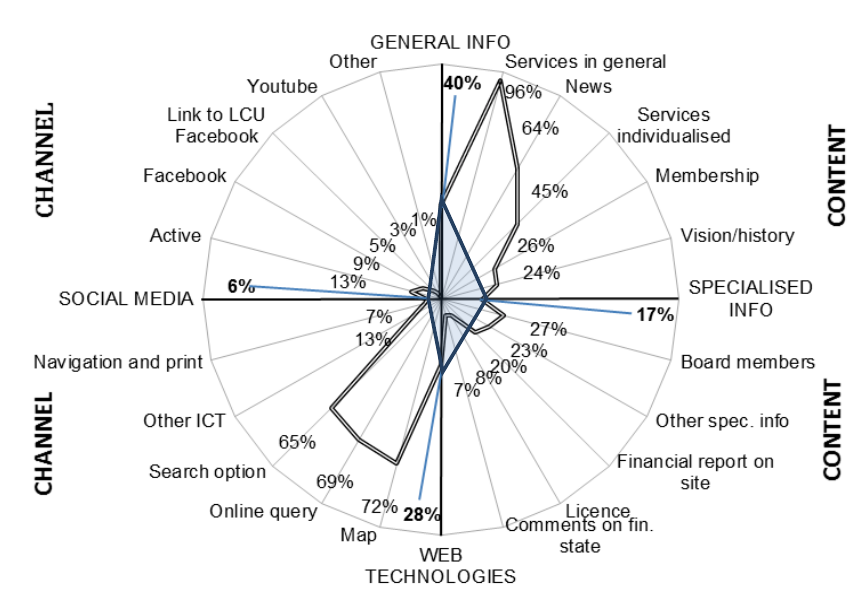
Fig. 4. E-transparency of CUs: presence of general and specialized information, use of technologies and social media. The data of Figure 4 and total mean values from Table 6 contribute to the conclusion that e-transparency of CUs, as tested in this research, is average, even if social media criteria would be